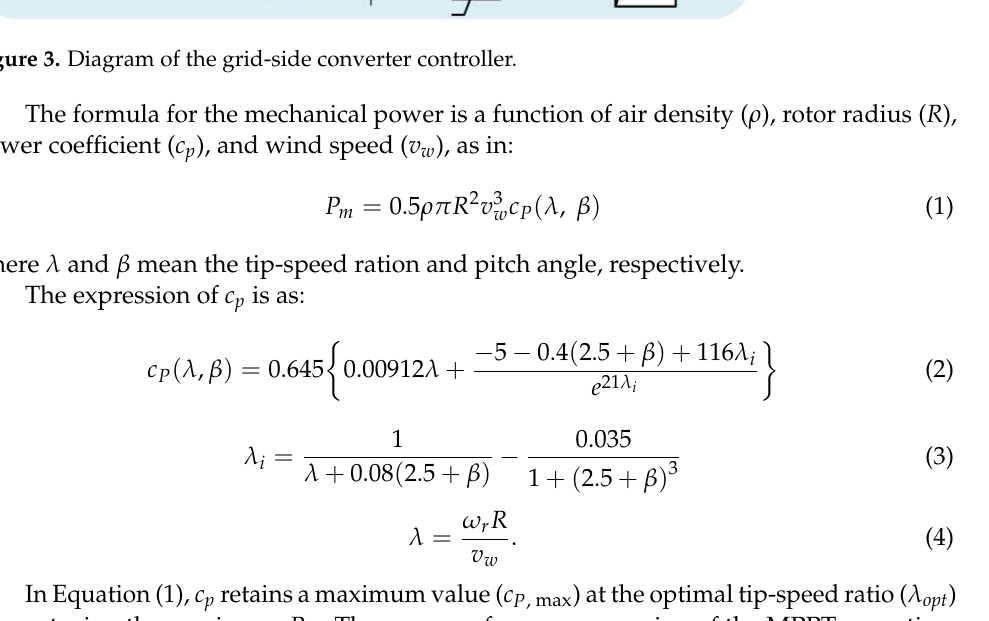
Figure 3. Diagram of the grid-side converter controller.